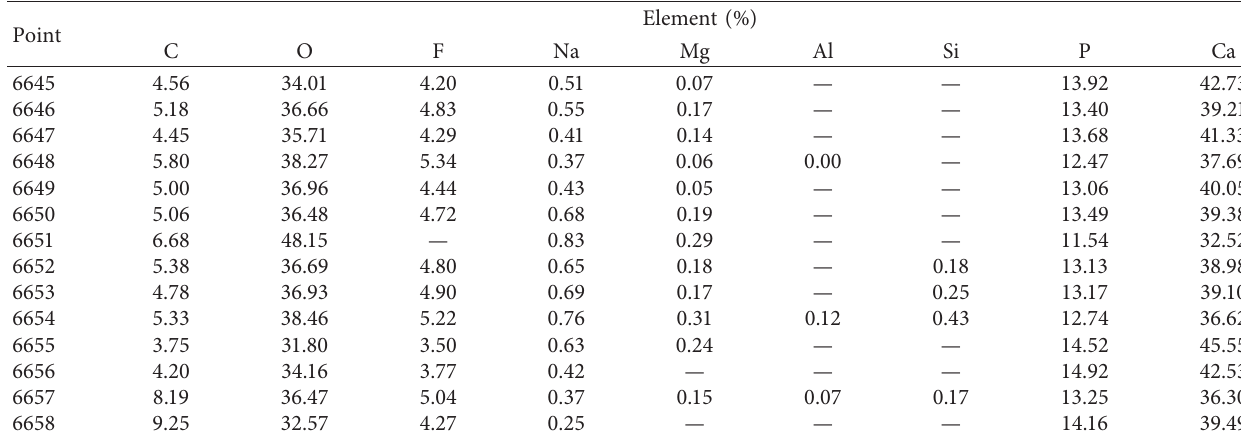
Figure 6: Backscattered electron diagram and energy spectrum of collophane oolite. Table 4: The energy spectrum analysis